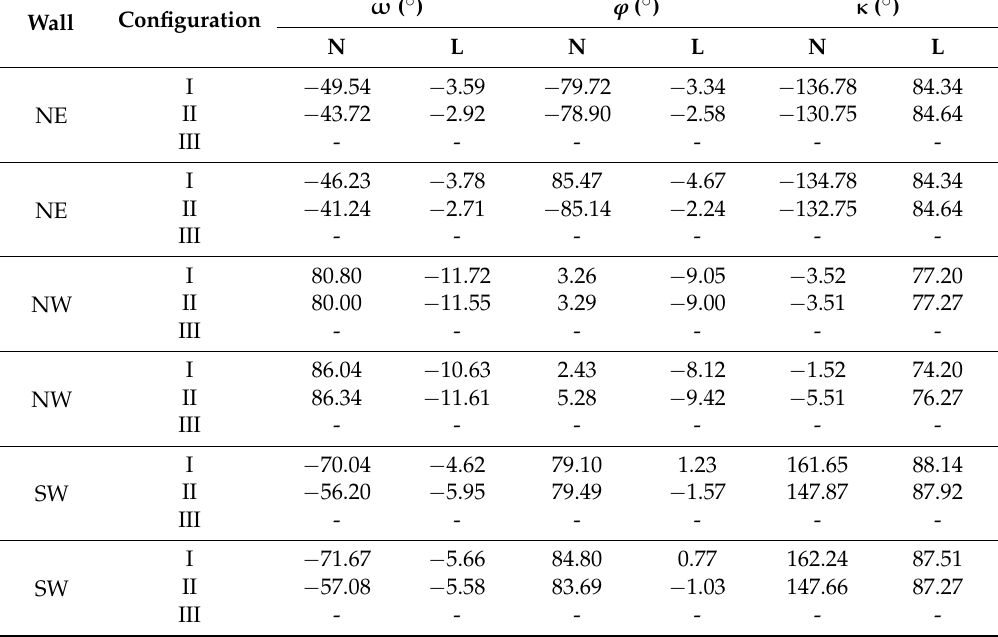
Table 6. Angular exterior orientation parameters calculated based on measuring control points distributed in different configurations.